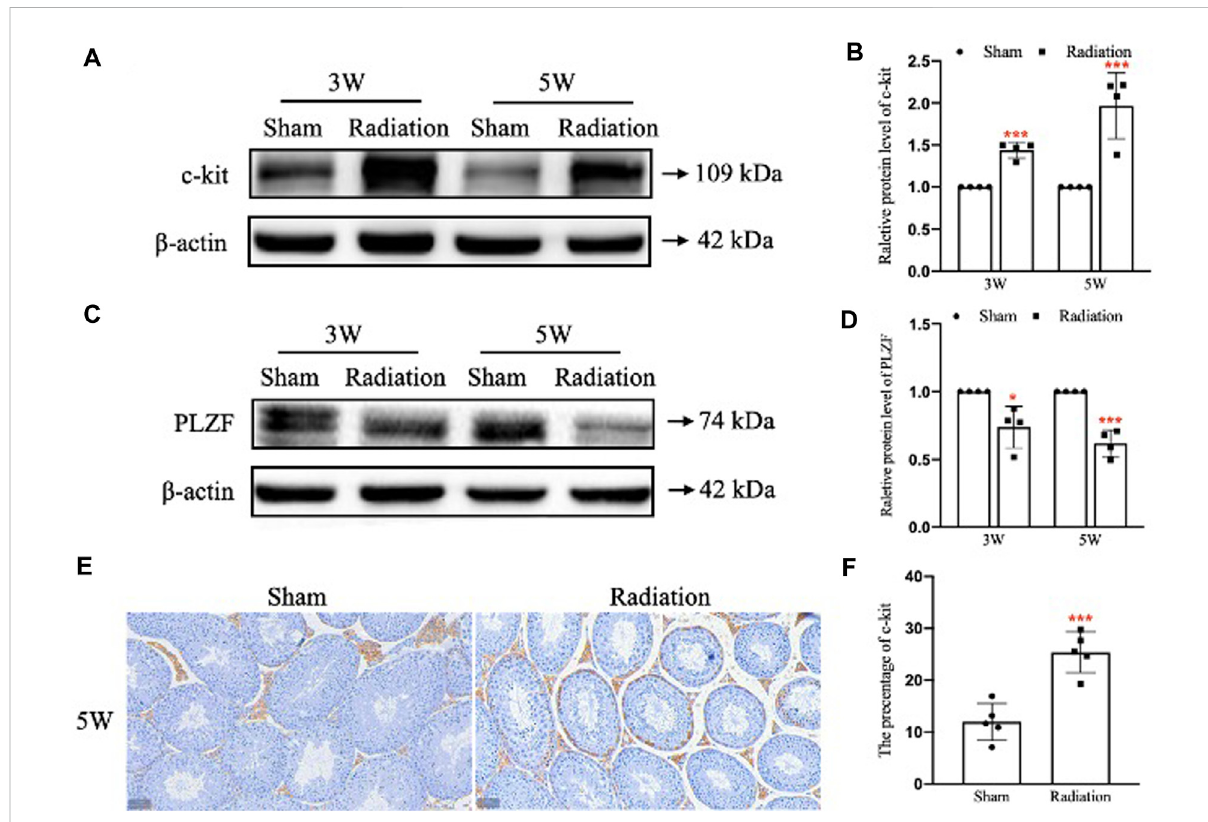
FIGURE 5 AbscopaleffectsofthoracicX-ray irradiation onspermatogonia stemcellsinmice. (A,B) Relative proteinlevelofc-kit detectedbyWB, n =4for each group. (C,D) Relative protein level of PLZF detected by WB, n = 4 for each group. (E,F) Immuno fl uorescence of c-kit and average fl uorescence intensity, Bar = 50 μ m (×200). The values are expressed as the mean ± SD, * p < 0.01; ** p < 0.01; *** p < 0.001 vs. sham